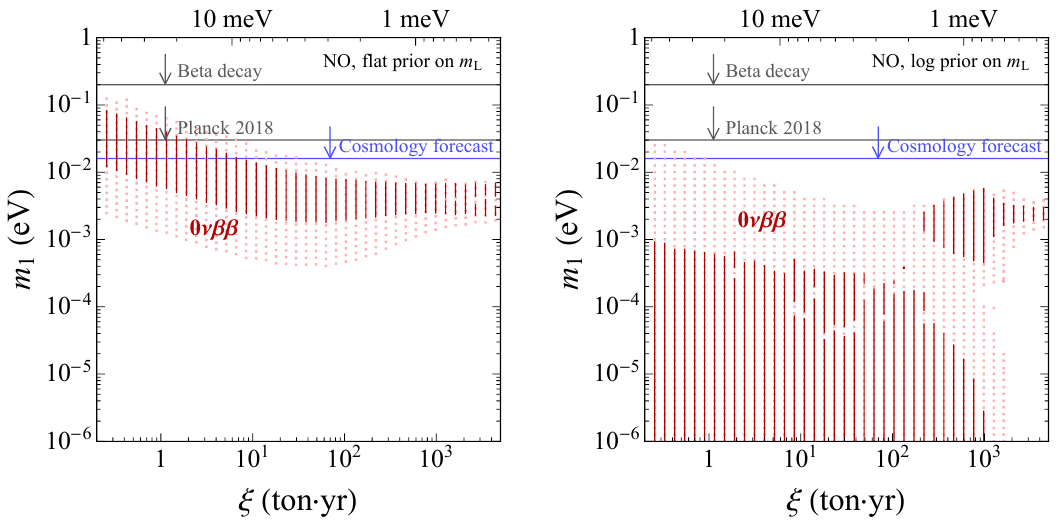
for different Figure 3 . The 68% (solid red lines) and 95% (dotted red lines) credible intervals of m 1 values of the exposure ξ with a vanishing background and a full efficiency (cid:15) = 1 . Null signal in future 0 νββ -decay experiments is assumed. The top horizontal axis signifies the corresponding 3 σ sensitivities to | m | with the average NME of |M | = 2 . 94 for 136 Xe 0 ν ββ